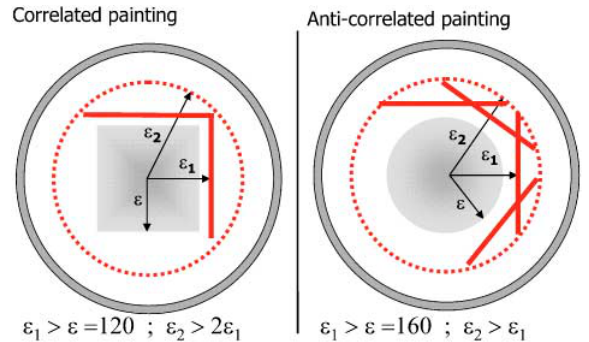
FIG. 7. (Color) Schematic view of the beam, pipe, and colli- mators in the real space x - y . For both cases, correlated and anticorrelated paintings are accommodated by adjusting the four scrapers of the primary